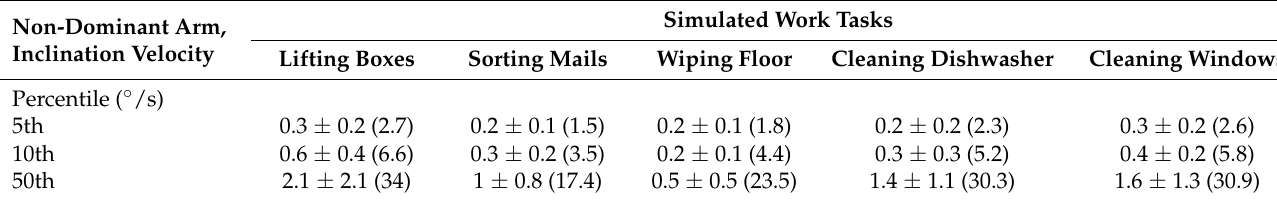
Table A2. The mean ± standard deviation of the mean absolute errors (MAEs) of the non-dominant arm inclination velocity between cloth sensors and skin sensors during the five simulated tasks, with the reference value of skin sensors shown in brackets ( n =